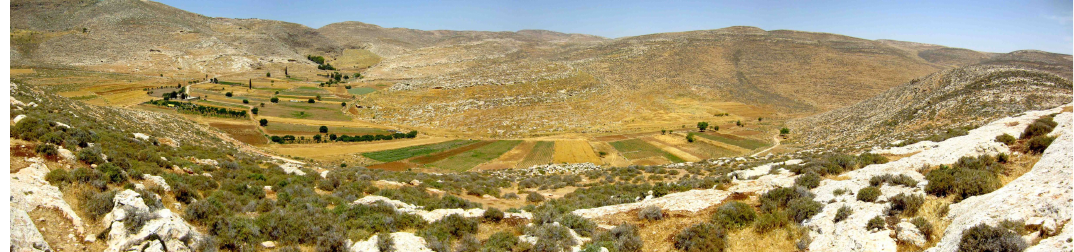
Figure 2. Typical hillslopes in the study area. The image shows the plain of Ein Samia with semi-arid climatic conditions, where the valley bottom is used for partly irrigated agriculture and the hillslopes are used as extensive grazing land for goats and sheep. The Wadi Auja ephemeral stream enters the plain from the left (west) and drains to the right (east) in direction to the Jordan